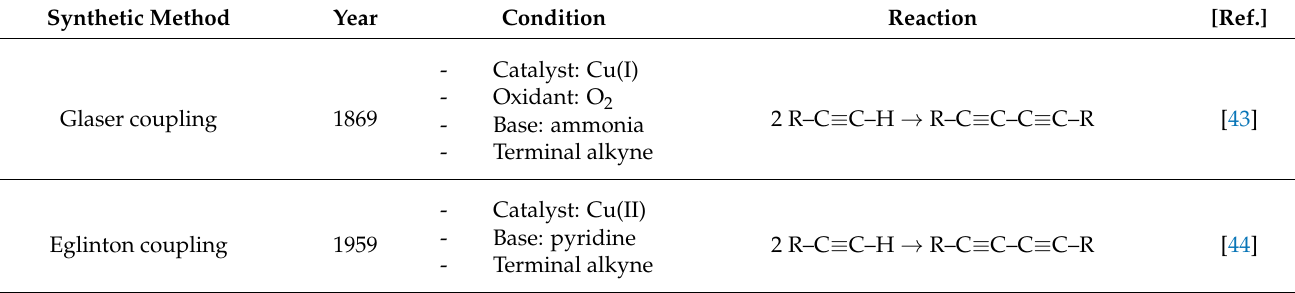
Table 1. Synthetic methods employed in cross-coupling or homocoupling reactions for the preparation of graphyne derivatives; year when a given method was invented is